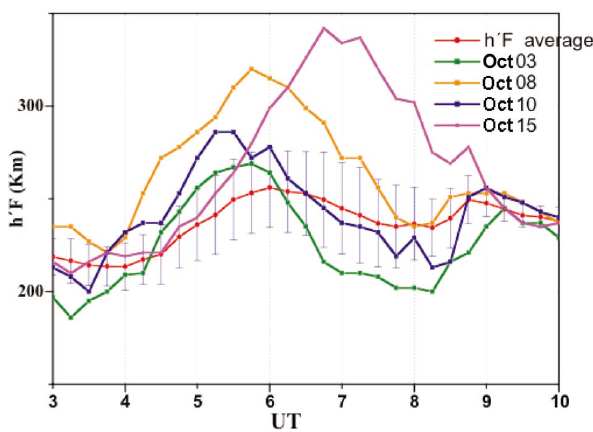
Fig. 3. Virtual height of the F peak for several days in October 2002 along with the monthly average as measured at Palmas,